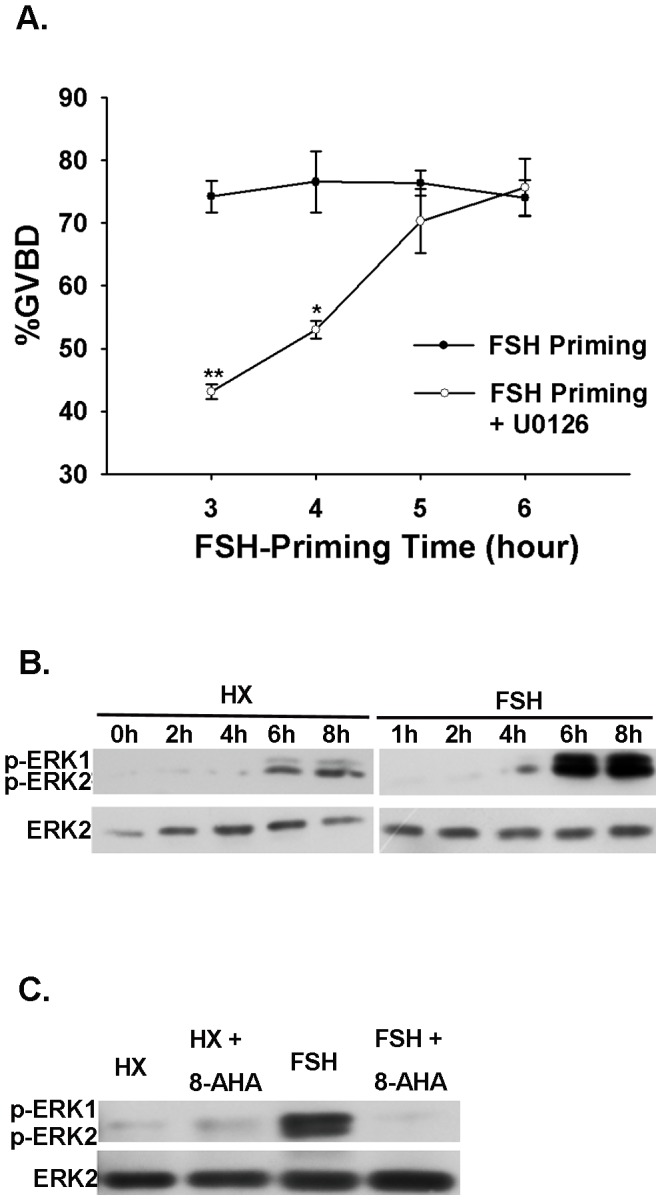
Correlations between FSH and MAPK and PKAI in oocytes.(A) Activation of MAPK in the oocytes of COCs was required for FSH-induced meiotic maturation. DOs from the COCs primed with FSH for 3, 4, 5, or 6 h were transferred to fresh HX medium containing the specific MAPK inhibitor U0126 and were further cultured for a total 22 h. U0126 significantly inhibited GVBD in DOs. Means marked with asterisks are significantly different (*P<0.05, **P<0.01). (B) FSH-activated MAPK in oocytes of COCs. Oocytes of COCs were collected after treatment with FSH for 0, 2, 4, 6, or 8 h for Western blot analysis of MAPK phosphorylation. (C) PKAI activation inhibited FSH-induced MAPK phosphorylation in oocytes of COCs. Oocytes from COCs were collected 8 h after treatment for Western blot analysis of MAPK phosphorylation. DOs from 100 COCs were collected at various time points for Western blotting. The blot shown is representative of three experiments.